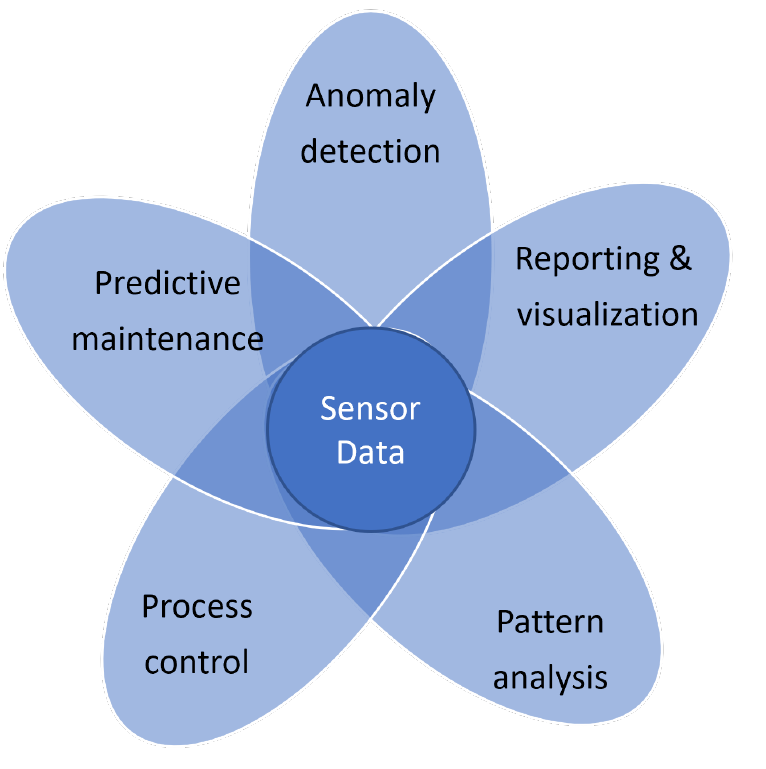
Figure 1. Sensor analyses